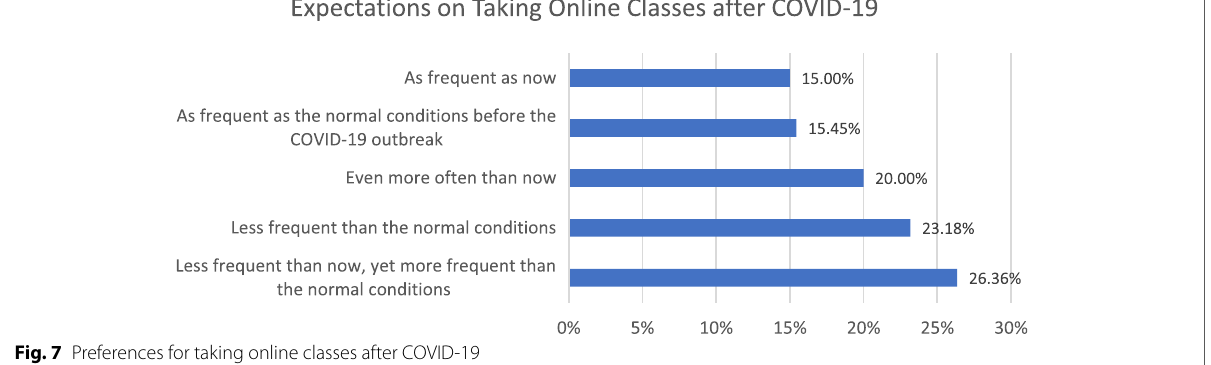
Fig. 7 Preferences for taking online classes after COVID-19